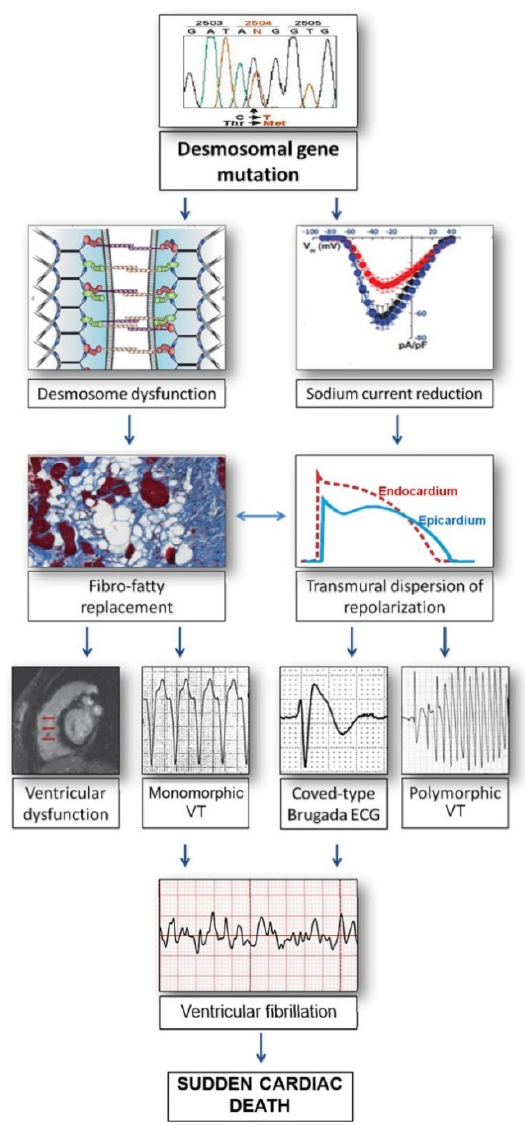
Figure 2. Relationship between arrhythmogenic right ventricular cardiomyopathy (ARVC) and Brugada Syndrome. Mutant desmosomal proteins may induce potentially lethal ventricular arrhythmias by causing gap-junction remodeling and modifying the amplitude and kinetics of the sodium current, as a consequence of the cross-talk between these molecules at the intercalated discs. According to this view, Brugada syndrome and ARVC may share clinical features and arrhythmic mechanisms because of their common origin from the connexome, a coordinated network of proteins involving desmosomes, sodium channels, and gap-junction, aimed to control synergistically adhesion, excitability, and coupling of myocardial cells [18–20]. ECG = electrocardiogram; VT = ventricular tachycardia. Modified from Ref [20] with permission of the publisher.